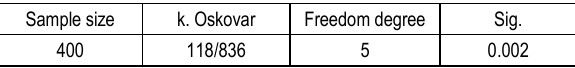
Table 6. Results of Friedman test (credit factors test) Sample